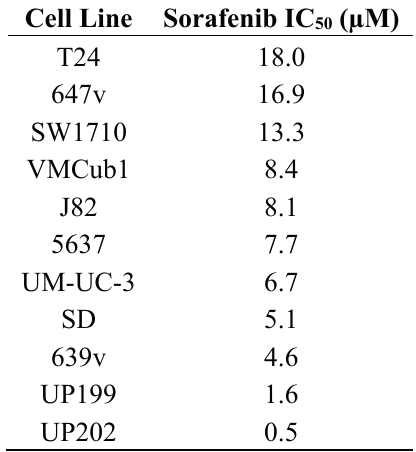
Table 1. Mean half maximal inhibitory concentrations (IC 50 ) values (cell viability) of urothelial cancer cell lines (UCCs) and normal uroepithelial controls (UP199, UP202) after 72 h of sorafenib treatment as determined by total adenosine triphosphate (ATP)